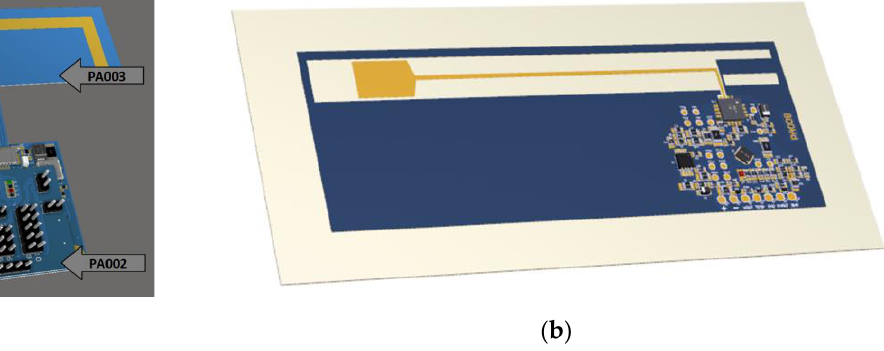
Figure 7. Two versions of RFID sensor: ( a ) research system based on three PCBs: PA001 — MEAS Part, PA002 — research interface part, PA003 — RFID Part; ( b ) single-board device.